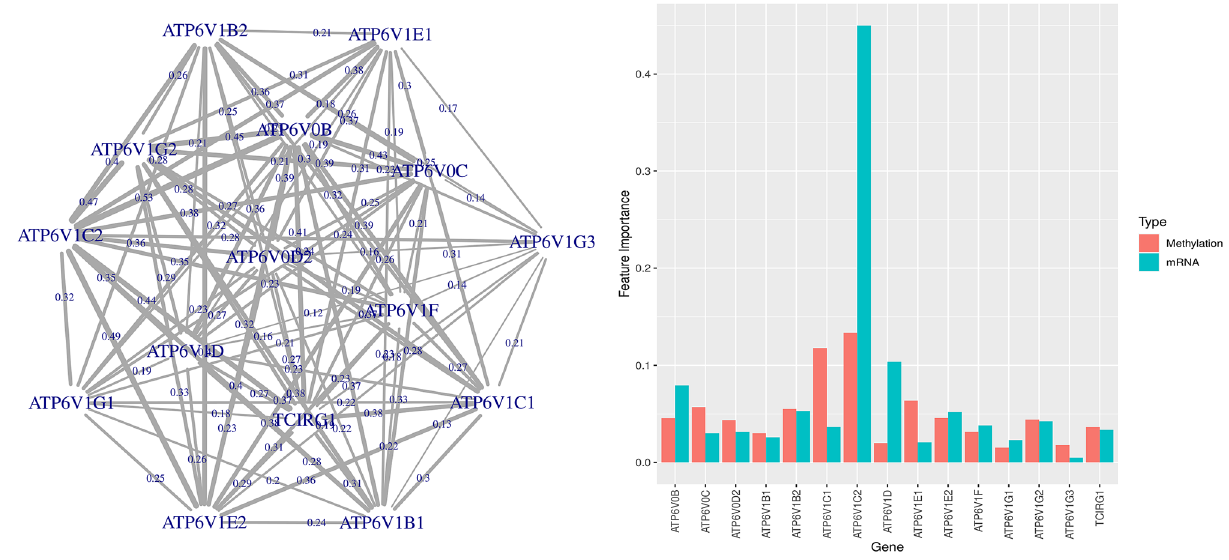
Figure 6. Disease module for classification of kidney cancer survival and non-survival patients. Left panel: disease subnetwork with importance of the edges ( Imp e ), indicated by edge thickness. Right panel: multi-modal importance measures of the involved omics ( IMP f ).